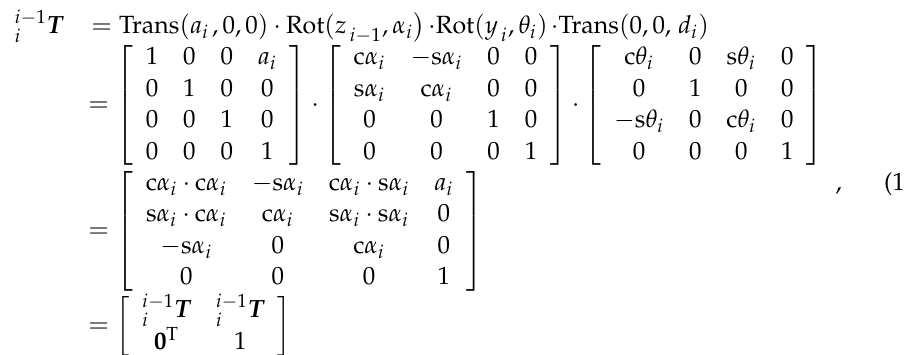
Figure 1. Simplified model and D-H coordinate system of an HRM. In order to analyze and solve the kinematics of the cable-driven HRM, the corre- sponding D-H coordinate system should be established. However, as a general solution method, the D-H method is not unified in its standards, which are often established with different rules and habits. In the traditional D-H coordinate system, the coordinate system shown in the first line of Figure 1 is used to establish the D-H coordinate system with 16 degrees of freedom, and the parameters of the D-H coordinate system in 16 lines need to be listed. In order to facilitate the calculation of the forward and inverse kinematics, 16 coordinate systems are simplified into 8 coordinate systems, as shown in the middle row in Figure 1 in this paper, which are presented in Table 1. The transformation matrix be- tween the two coordinate systems can be obtained by making the coordinate {O i −1 } trans- late ai along the X i −1 axis, rotating α i of Z i −1 , then rotating θ i to coordinate {O i }, and finally translating d i along Z i axis, as shown in Equation (1).